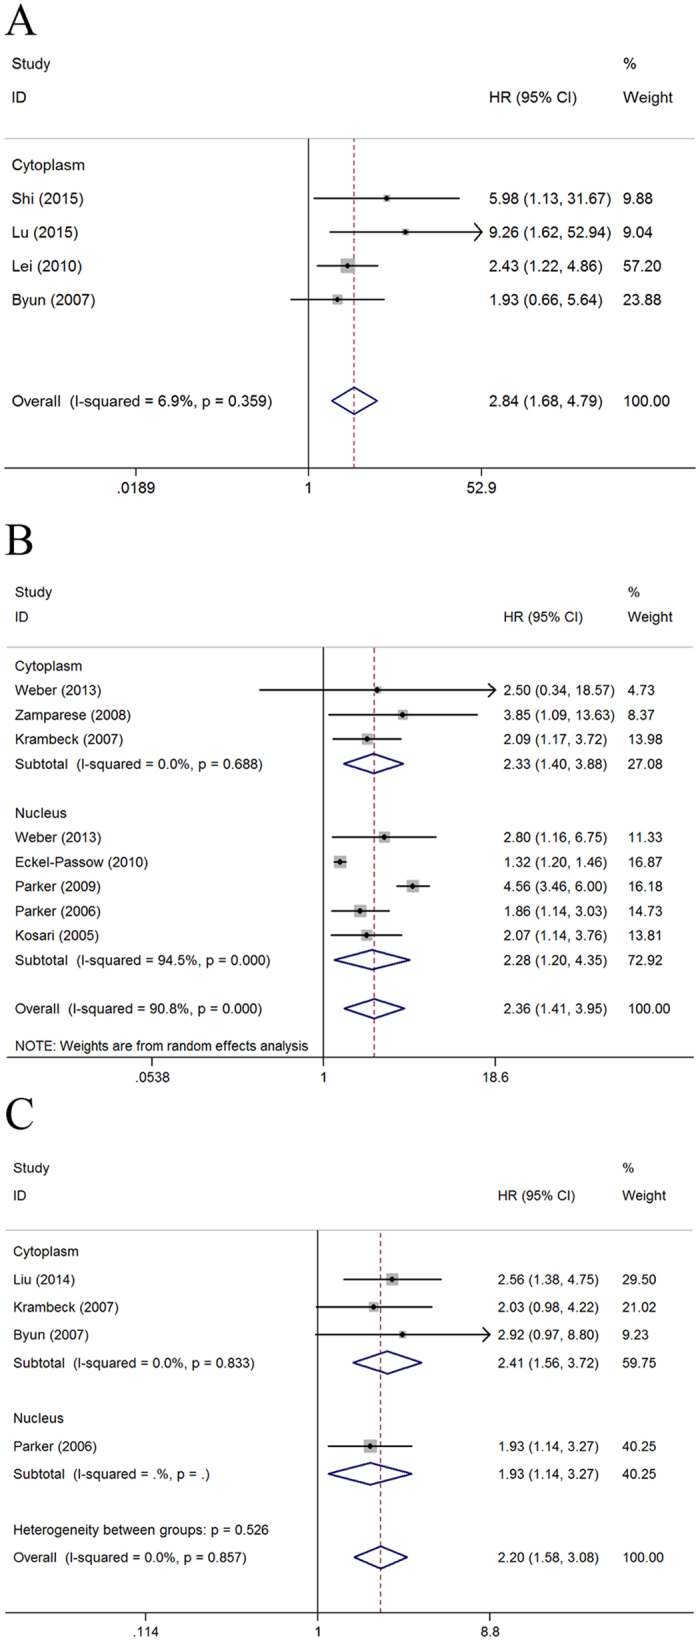
Forest plots of studies evaluating the association of survivin expression and prognostic outcomes of RCC patients and subgroup analysis in terms of different subcellular localization of survivin expression.(A) effect of survivin overexpression on OS, (B) CSS, and (C) PFS. HR: hazard ratio; CI: confidence interval; OS: overall survival; CSS: cancer-specific survival; PFS: progression-free survival; RCC: renal cell carcinoma. HR > 1 implies unfavorable prognosis for patients with high survivin expression.